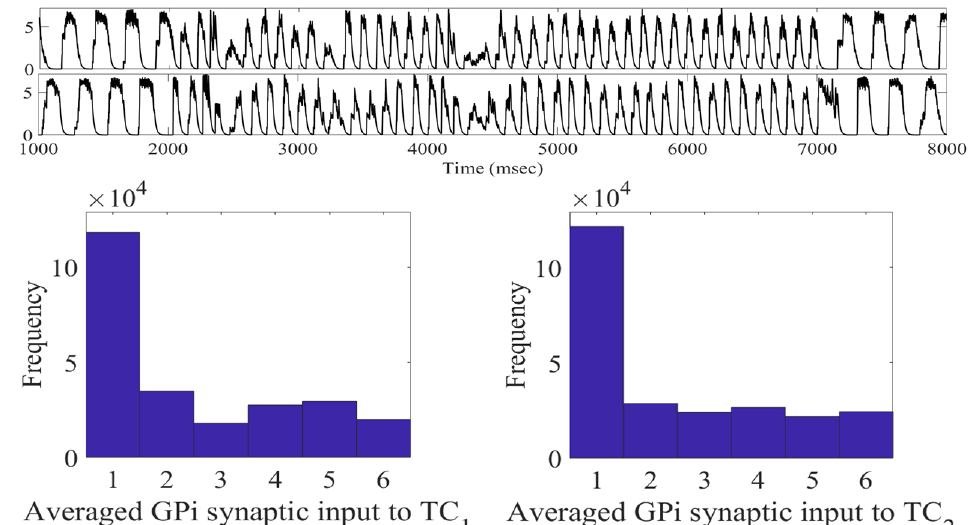
Figure 7. Total GPi synaptic inputs sg 1 and sg 2 ( top traces ) with corresponding histograms of sg ( left ) and sg ( right ) during the treatment window when acDBS was applied with a 0 = − 24 and 2 intt =